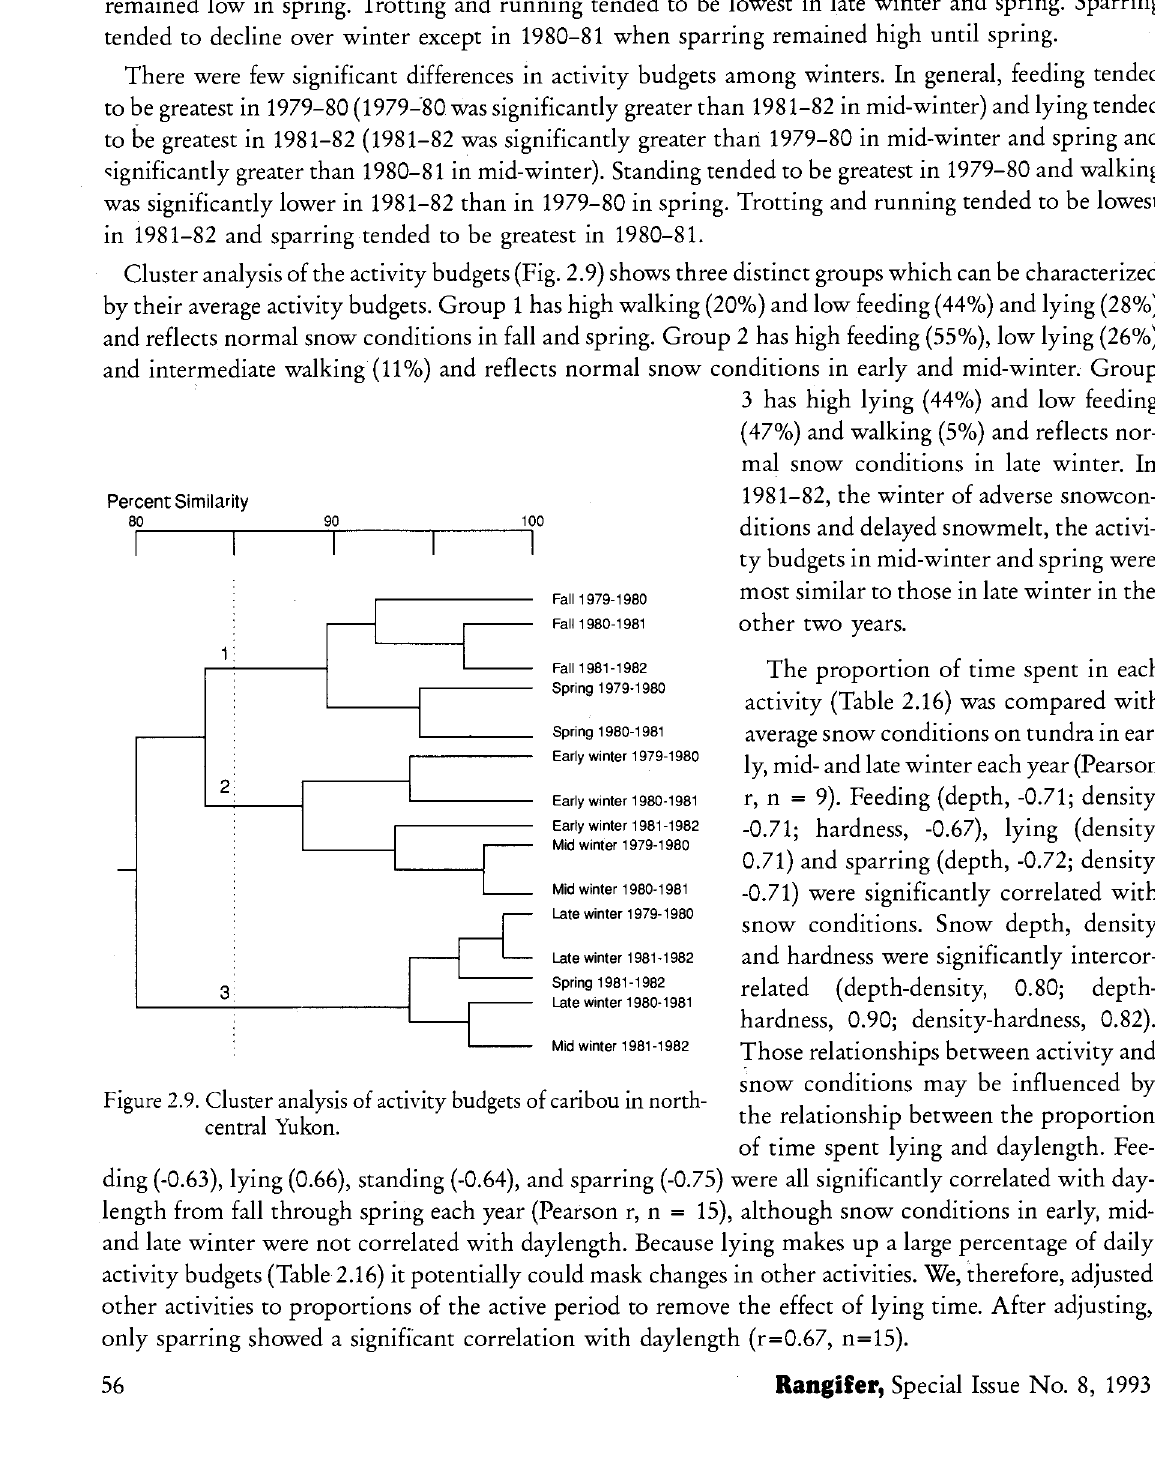
Figure 2.9. Cluster analysis of activity budgets of caribou in north- central